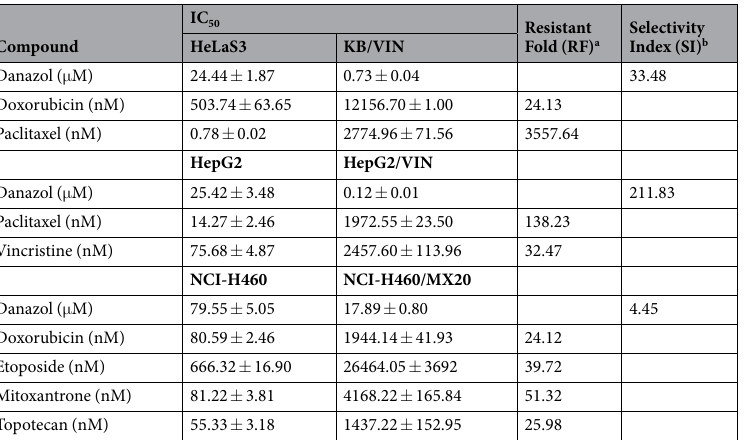
Table 1. Selectivity Index of Danazol on several multidrug-resistant cancer cell lines. a The resistant fold was calculated by dividing the individual IC 50 of MDR cell line (KB/VIN, HepG2/VIN, or NCI-H460/MX20) by the IC 50 of parental cell line (HeLaS3, HepG2, or NCI-H460). b The selectivity index was calculated by dividing the individual IC 50 of parental cell line (HeLaS3, HepG2, or NCI-H460) by the IC 50 of MDR cell line (KB/VIN, HepG2/VIN, or NCI-H460/MX20).